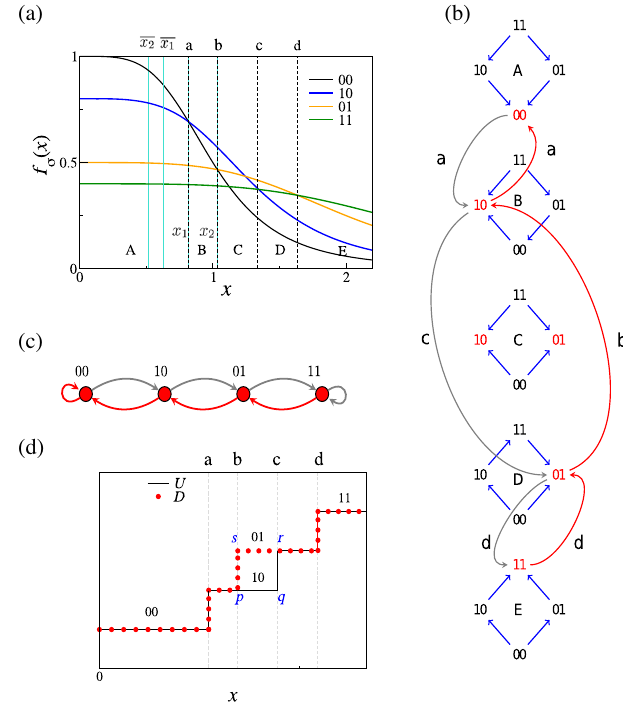
FIG. 2. Trade-off-induced fitness landscapes (TIL) model. (a) Fitness curves for four genotypes in a TIL model with two sites ( L ¼ 2 ), with parameters r 1 ¼ 0 . 8 , m 1 ¼ 1 . 3 and r 2 ¼ 0 . 5 , m 2 . The shape of the curve is the Hill function w ð x Þ ¼ 2 ¼ 1 = ð 1 þ x 4 Þ [49,51]. The figure is divided into five regions A – E, corresponding to different fitness graphs. A new fitness graph occurs when the fitness curves of two mutational neighbors intersect. The x values of the intersection points are marked by the letters a – d. The elements x 1 ; x 2 ; ¯ x 1 ; ¯ x 2 of the ordering sequence (see main text) are indicated by solid vertical lines. (b) Fitness graphs in the regions A – E. Concentration x increases in the downward direction. In each fitness graph, the local fitness maxima (LFMs) are marked in red. Evolution in a fitness graph follows the oriented edges until a fitness maximum is reached. The curved gray arrows follow the evolution of the system under quasistatic increase of x starting from the stable state 00 at x ¼ 0 until the all-mutant 11 is reached; the curved red arrows continue the trajectory as the concentration is quasistatically decreased until 00 is reached again. (c) Transition graph for the two-site system is shown. This should be distinguished from the fitness graphs in (b). The nodes of the transition graph are the stable states which, in this simple case, comprise all genotypes. The gray arrows are the U transitions, i.e., the transitions under concentration increase, and the red arrows are the D transitions, i.e., transitions under concentration decrease. The transition graph can be read off from the sequence of fitness graphs in (b). (d) The transition between states is shown schematically. Each horizontal level is a genotype, and the vertical lines denote transitions. The black lines correspond to genotypes reached under U transitions (starting from 00 at x ¼ 0 ), while the line traced out by the red dots indicates the genotypes reached under D transitions (starting from 11 at large x ). The hysteresis loop pqrs is